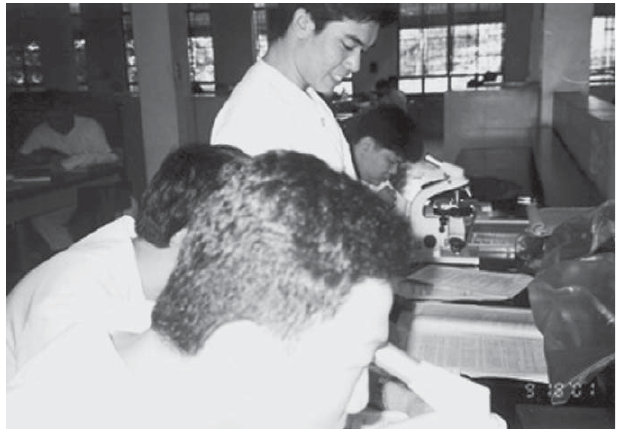
Fig. 1. Medical students in a pathology laboratory sharing microscopes and slides.